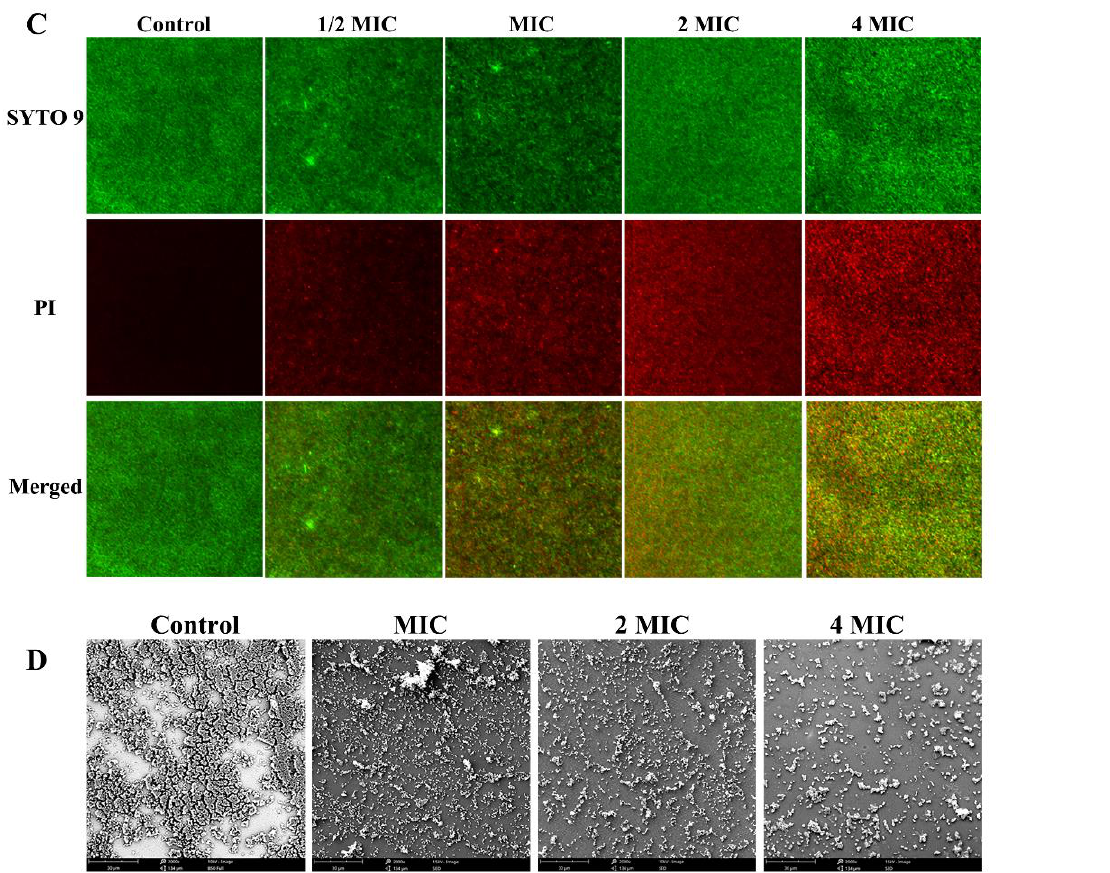
Figure 2. Effect of PEO on biofilm of S. mutans . ( A ) PEO suppresses the total biofilm biomasses with the increase of concentration (* p < 0.05, ** p < 0.01, *** p < 0.001). ( B ) PEO decreases the bacterial activities within biofilm with the increase of concentrations. ( C ) Representative fluorescent images of cell viability within biofilm using Live/Dead ® BacLight TM Bacterial Viability kit. ( D ) SEM-representative images of biofilms after treatment with or without PEO using SEM. 1/4MIC, 0.15625 µ L/mL; 1/2MIC, 0.3125 µ L/mL; MIC, 0.625 µ L/mL; 2MIC, 1.25 µ L/mL; 4MIC, 2.5 µ